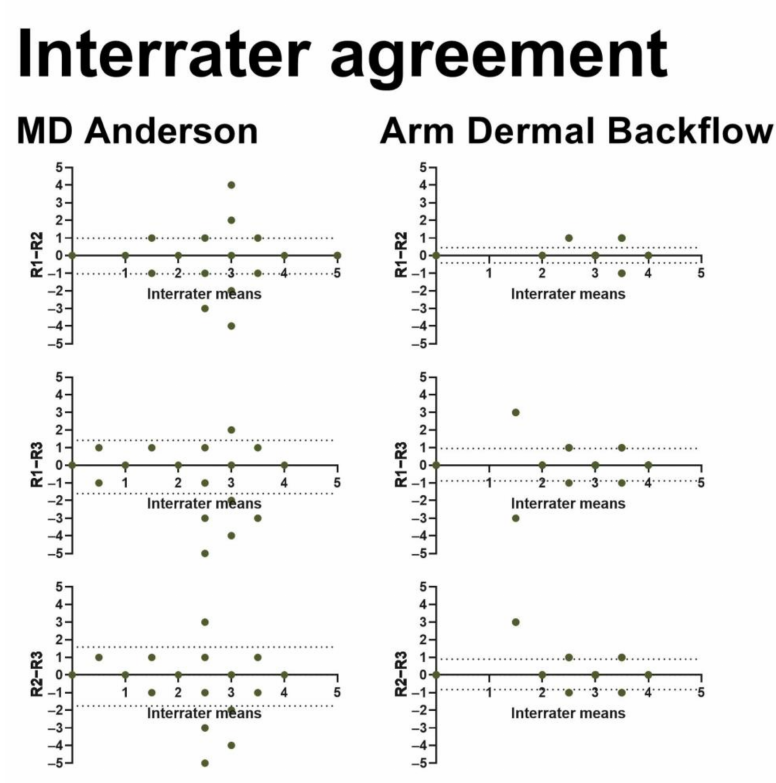
Figure 2. This figure shows Bland–Altman plots for interrater agreements in MDA and ADB scales. The x-axis represents the mean interrater stage (range: 0–5). The y-axis shows the difference in interrater staging (range: − 5–5). R1= rater 1, R2 = rater 2, R3 = rater 3. The horizontal dotted lines denote the 95% confidence intervals for the limits of agreement.